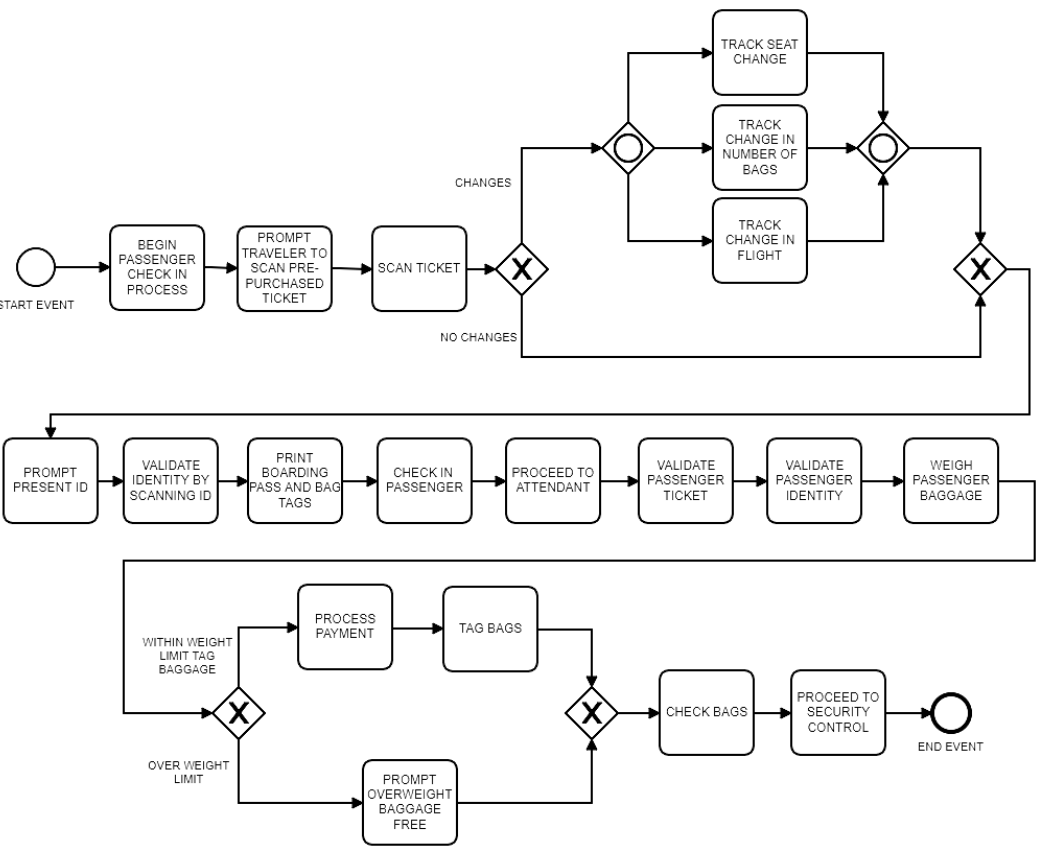
Figure 3. Boarding procedure model after normalization.